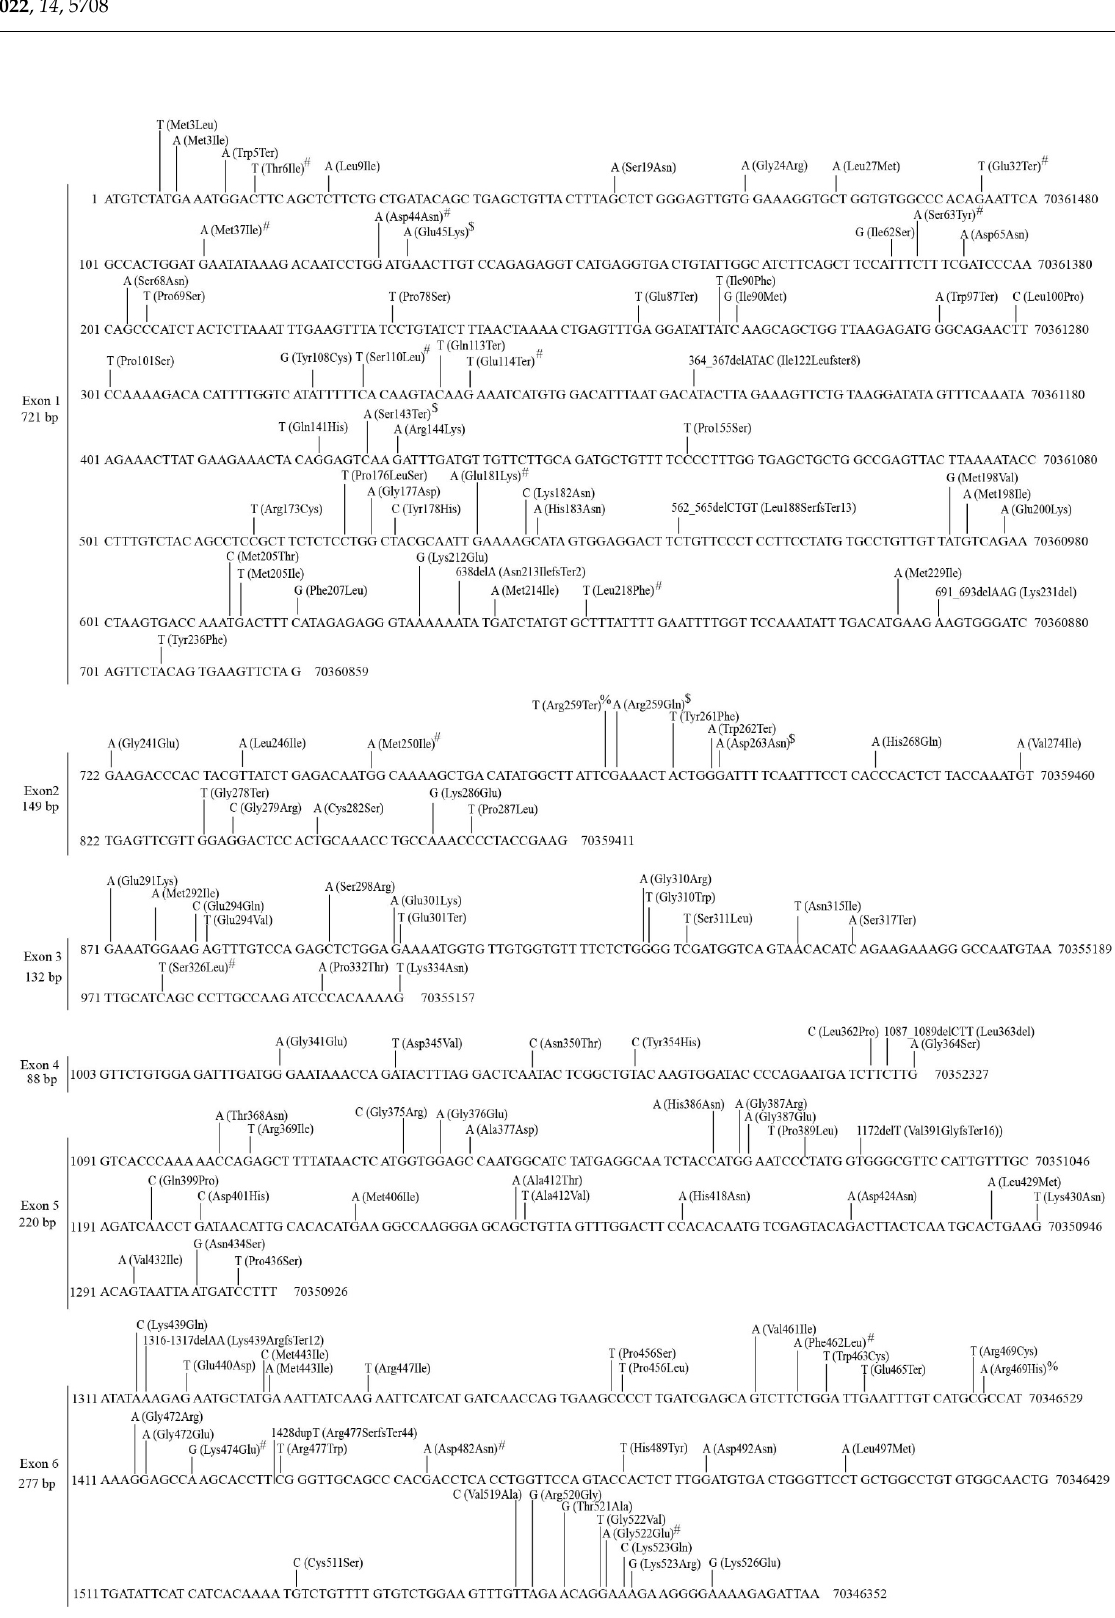
Figure 5. Mutations in the UGT2B4 gene in TCGA cancers. Data shown are the NCBI UGT2B4 reference sequence (6 exons, 1587 bp) with genomic (GRCh37/hg19, right) and cDNA (NM_021139.3, left) positions. Mutations (missense, nonsense and small indels) and the resulting changes at the protein level (NP_066962.2) are indicated above the reference mRNA sequence. Recurrent mutations are indicated by # (twice), $ (three times) and % (four